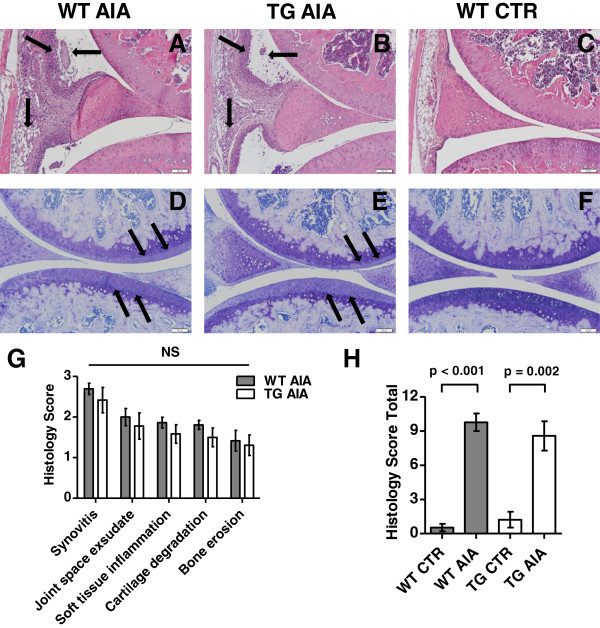
Arthritis and cartilage damage in the knee joint 14 days post intra-articular injection. (A-F) Representative histologic sections of knee joints from wild-type (WT) and transgenic mice (TG) treated with mBSA (AIA) and from non-arthritic wild-type control mice (CTR). Both inflammatory activity and cartilage damage were similar in transgenic mice and wild-type mice treated with mBSA. (A–C) Hematoxylin and eosin staining. Arrows show synovitis, joint space exudate and soft tissue inflammation. Bars = 100 μm. (D–F) Toluidine blue staining. Arrows show proteoglycan loss of articular cartilage. Bars = 100 μm. (G-H) Histopathology scores (G single, H total) in mBSA-treated mice (AIA) 14 days post injection. The knee joints of all mice were assessed as described in Materials and Methods. Bars show the mean ± SEM. Findings in arthritic wild-type AIA mice and arthritic transgenic AIA mice for single scores were compared by Mann–Whitney test. Total scores were compared between the 4 groups with adjustment for 4 parallel tests (α* = 0.0125). NS = not significant (see Figure 1 for other definitions).